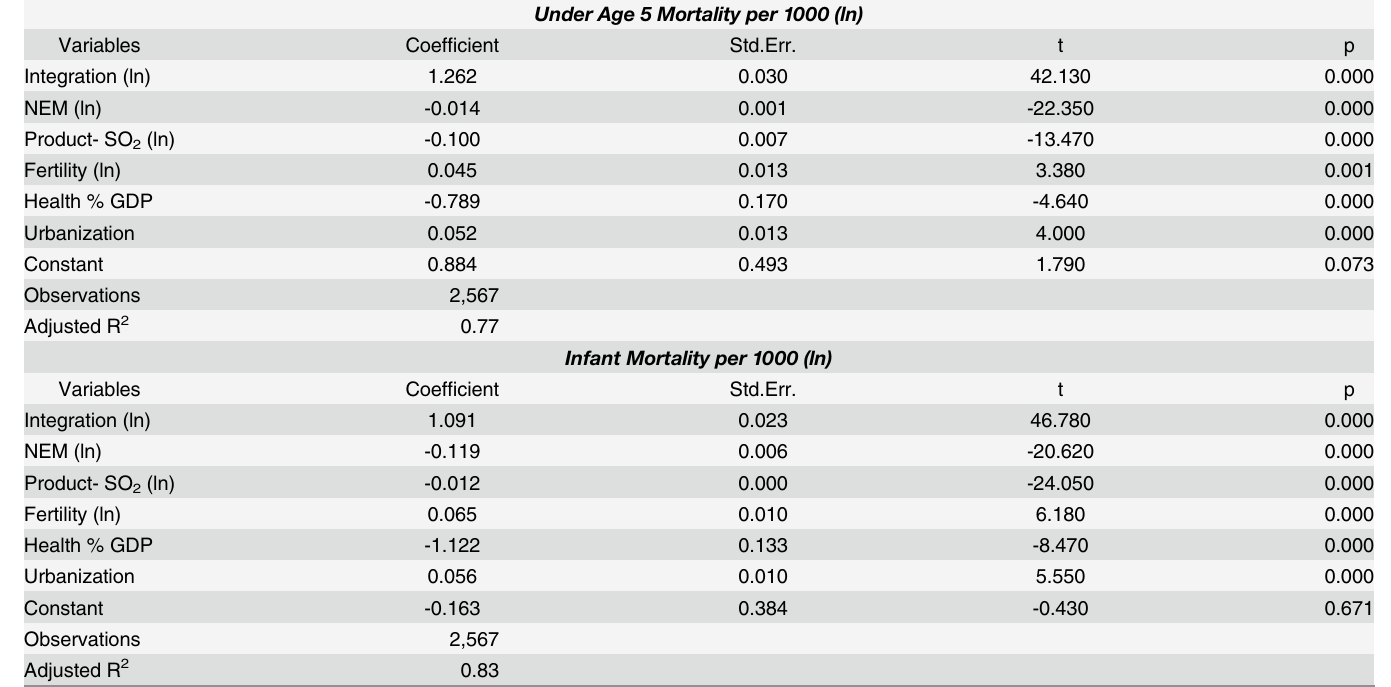
Table 7. Stepwise Regression Results for Infant and Child Mortality.